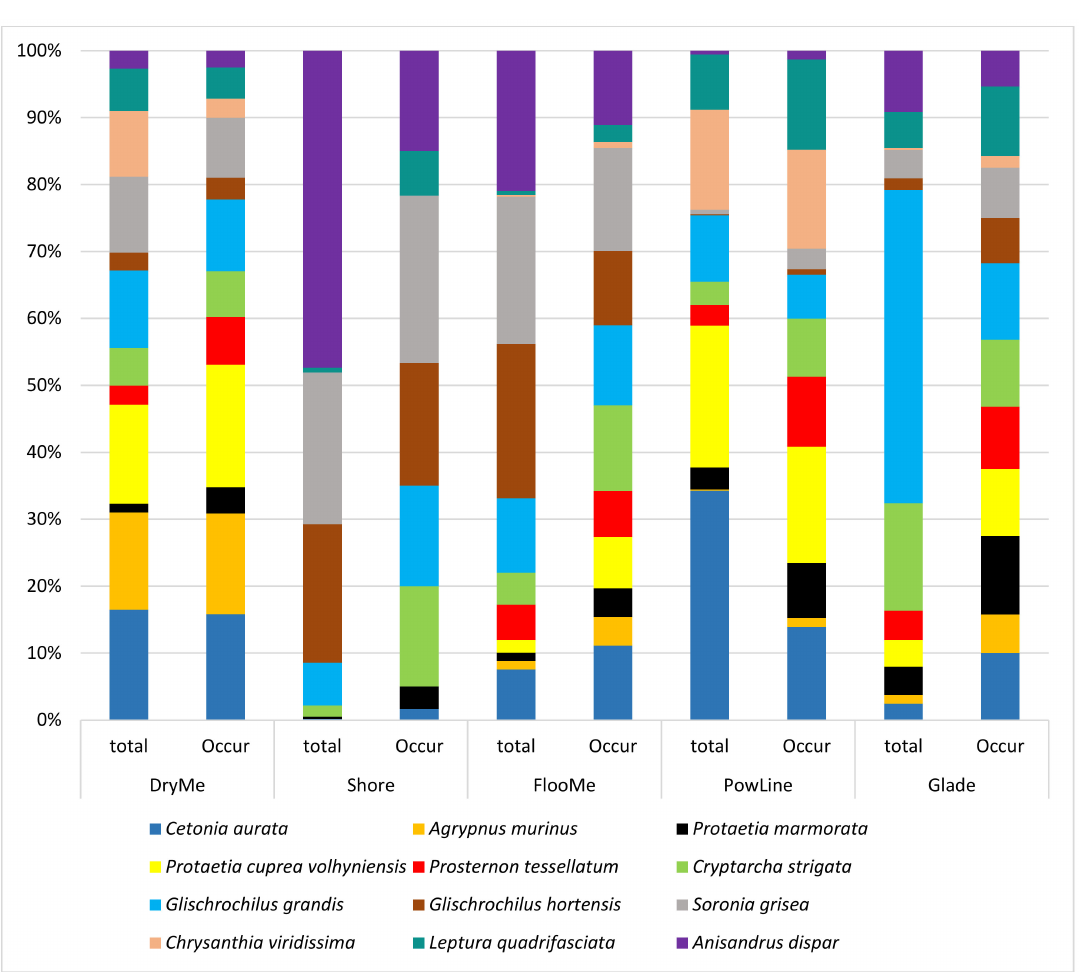
Figure 5. Absolute abundance and total occurrence of some Coleoptera species in selected